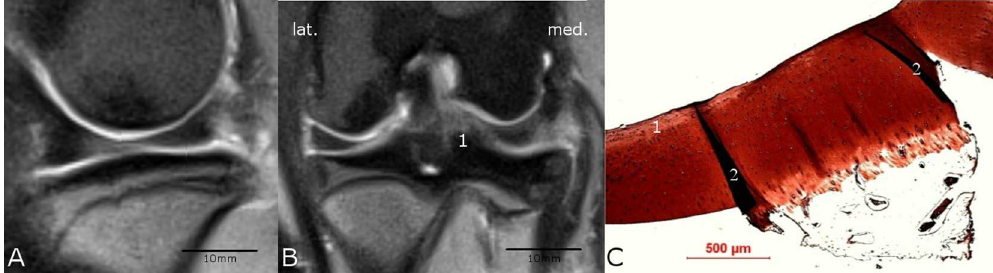
Fig 4. Comparison of MRI (A and B) with histological findings (C). The medial tibia plateau region of the ACLR knee joint of animal #8952 showed in the sagittal MRI-scan (A) through the medial compartment no salience but in the coronal MRI-scan (B) a signal irregularity (1) of the normally bright appearingcartilage was present and was therefore rated as pathological; no cyst or osteophytes were present. The scale bars for A and B were determinedwith the program RadiAnt DICOM viewer (see caption Fig 1). C) The histological safranin-o staining showed a mild degeneration (Little-score: 4.0 points) with only a slight reduction in staining (1). The darker formations in the cartilage (2) were interpreted as creases of the slice and were not includedin the scoring. Thus, the histological and MRI findings did not